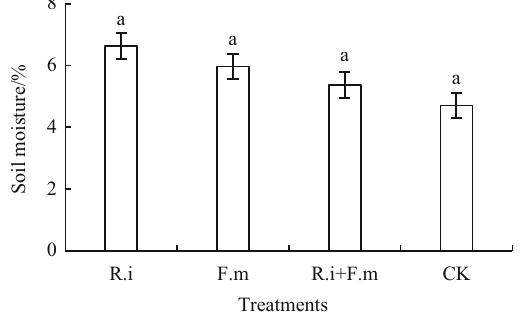
Fig. 3 Effect of AM inoculation on soil moisture of Amygdalus pedunculata Pall.